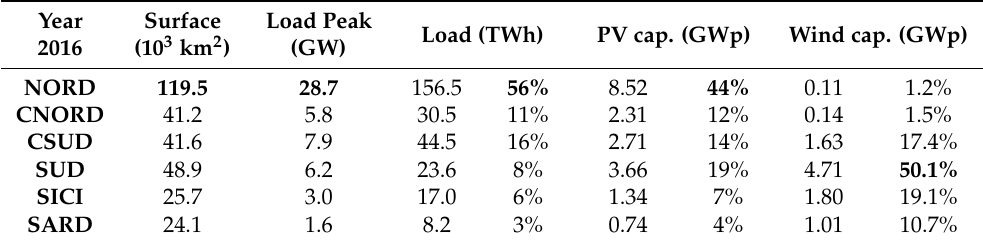
Table 1. Surface and 2016 annual electricity demand and VRE generation of the Italian market zones. (bold indicates areas with greater load or greater VRE capacity).